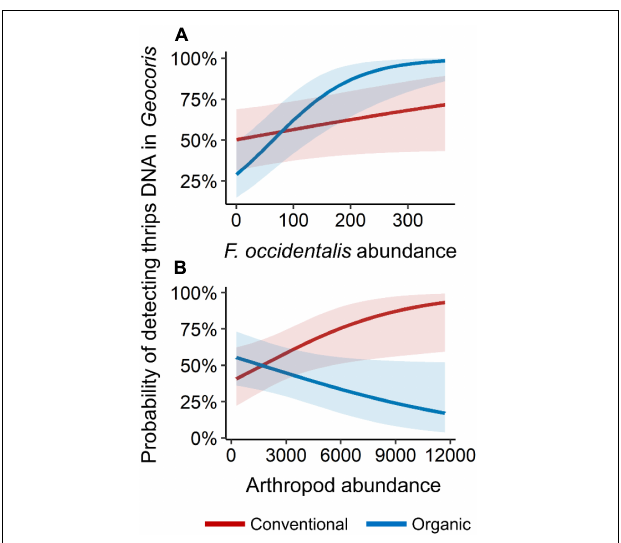
FIGURE 2 | Probability of detection of western flower thrips DNA in Geocoris versus (A) western flower thrips abundance and (B) total arthropod abundance. Figure shows the predicted values from the best-supported models using the “plot_model” function in the sjPlot package in R. Red lines indicate conventional fields (red bands are 95% confidence intervals) and blue lines indicate organic fields (blue bands are 95% confidence intervals). X -variables were standardized in the candidate model set but are plotted on the original scale for